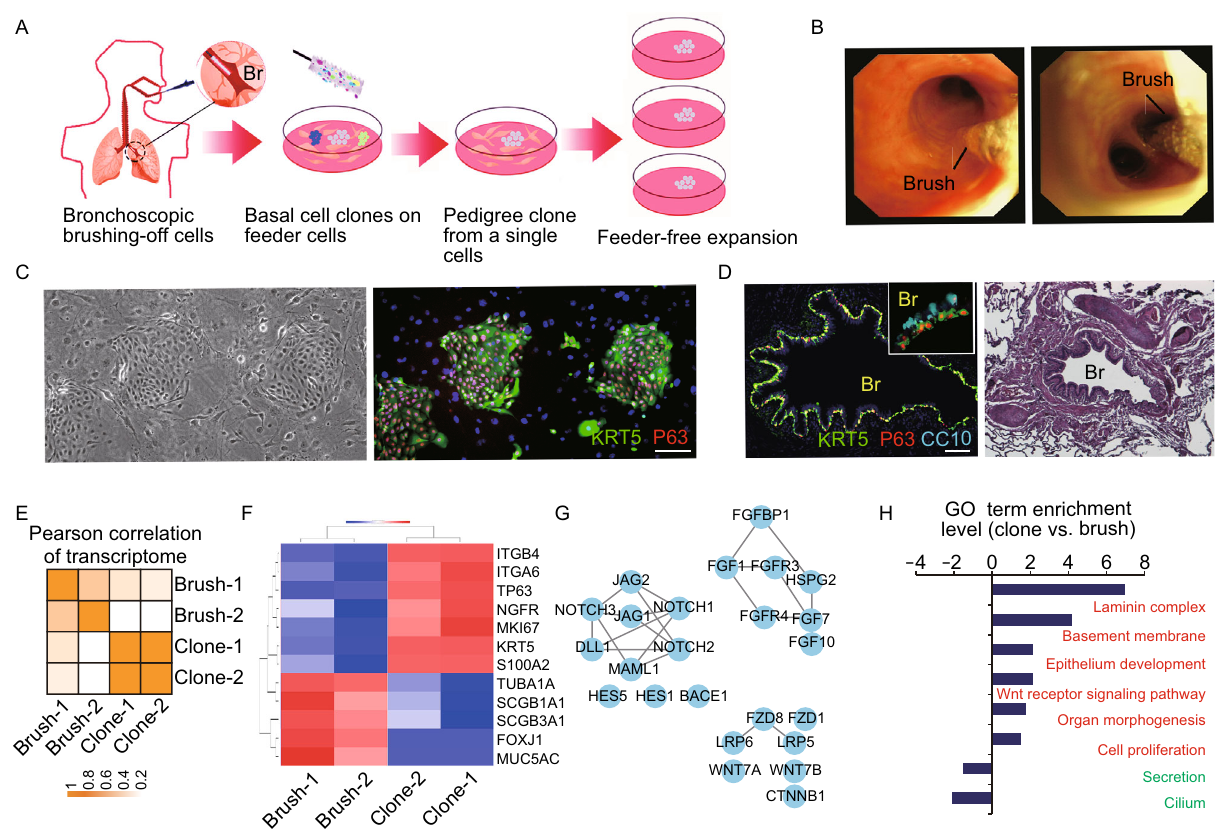
Figure 1. Isolation and characterization of BCs from SOX9 + human airway. (A) Diagram showing the process of clonogenic BCs isolation and expansion. (B) Bronchoscopic image showing brushing of cells from human airway. (C) Left, BC colonies grown on feeder cells; right, anti-KRT5 and anti-P63 immunostaining of BC colonies with nuclei counterstain. Human sample number n = 10. Scale bar, 100 μ m. (D) Left, BCs in human airway by anti-KRT5 and anti-P63 immunostaining. Inset, high magni fi cation with club cell (CC10+, cyan color) costaining; right, hematoxylin & eosin staining of the same section. Br, bronchus. Scale bar, 100 μ m. (E) Heatmap showing transcriptome pro fi le correlation value of BC clones and brush-off tissues. (F) Expression heatmap of selected, differentially expressed genes ( P < 0.05) comparing BC clones and brush-off tissues. (G) Protein-protein interaction network of selected genes with high expression level in BC clones. (H) Enriched gene ontology classes of BC clones versus